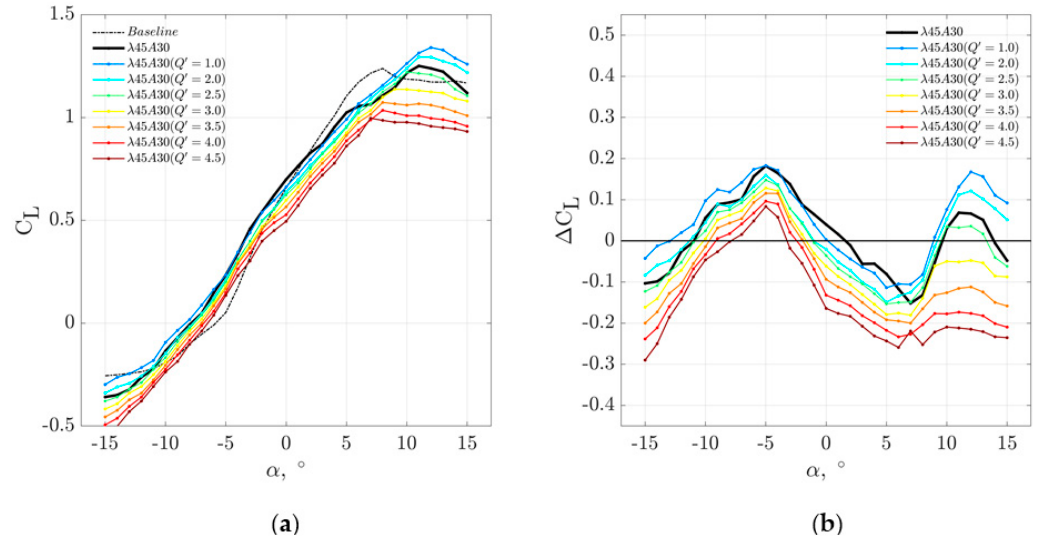
Figure 12. Comparison of the ( a ) C L as a function of α produced by the baseline and hybrid ( λ 45 A 30 + blowing Q ‘ ) leading edge device at U = 25 ms − 1 . The leading edge blowing range covers 0.0 (serration only) ≤ Q ‘ ≤ 4.5 L/min, and ( b ) The corresponding Δ C L as a function of α , where Δ C L is the difference in C L between the hybrid ( λ 45 A 30 + Q ‘ = 0.0–4.50 L/min) and the baseline.